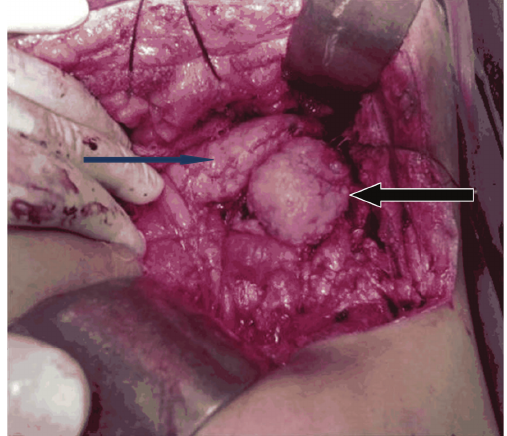
Figure 2: The blue arrow shows pancreas and the black arrow shows Castleman’s